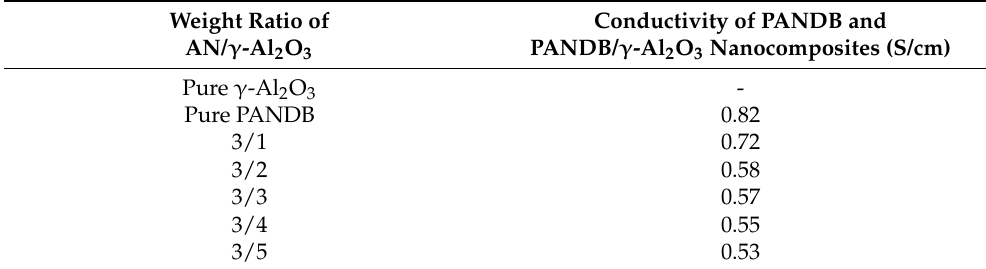
Table 1. Influence of the weight ratio of AN/ γ -Al 2 O 3 on the electrical conductivity of PANDB/ γ - Al 2 O 3 core–shell nanocomposites.